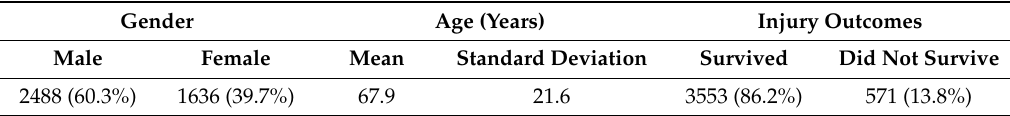
Table 3. Information summary for adult TBI cases (total 4124) included in the